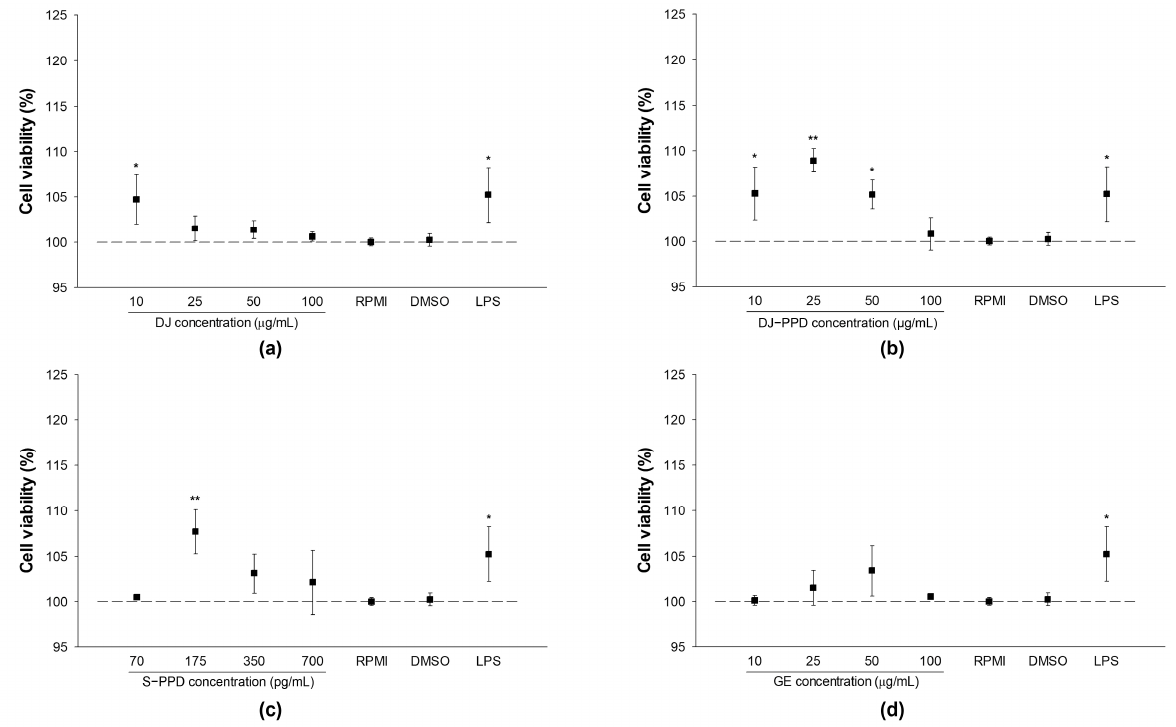
Figure 2. Cell viability in cells pretreated with ( a ) DJ extract, ( b ) DJ-PPD extract, ( c ) S-PPD, and ( d ) GE extract. Treated cells were incubated for 24 h before cell viability measurement. The concentra- tion of DMSO and LPS was 0.1%. LPS was used as a positive at 1 µg/mL. Data are shown as means ± standard deviation ( n = 3). Significant differences at p < 0.05 (*) and p < 0.01 (**) were determined by comparison with the RPMI group. Table 2. DJ, DJ-PPD, S-PPD, and GE treatments enhanced NO production in RAW264.7